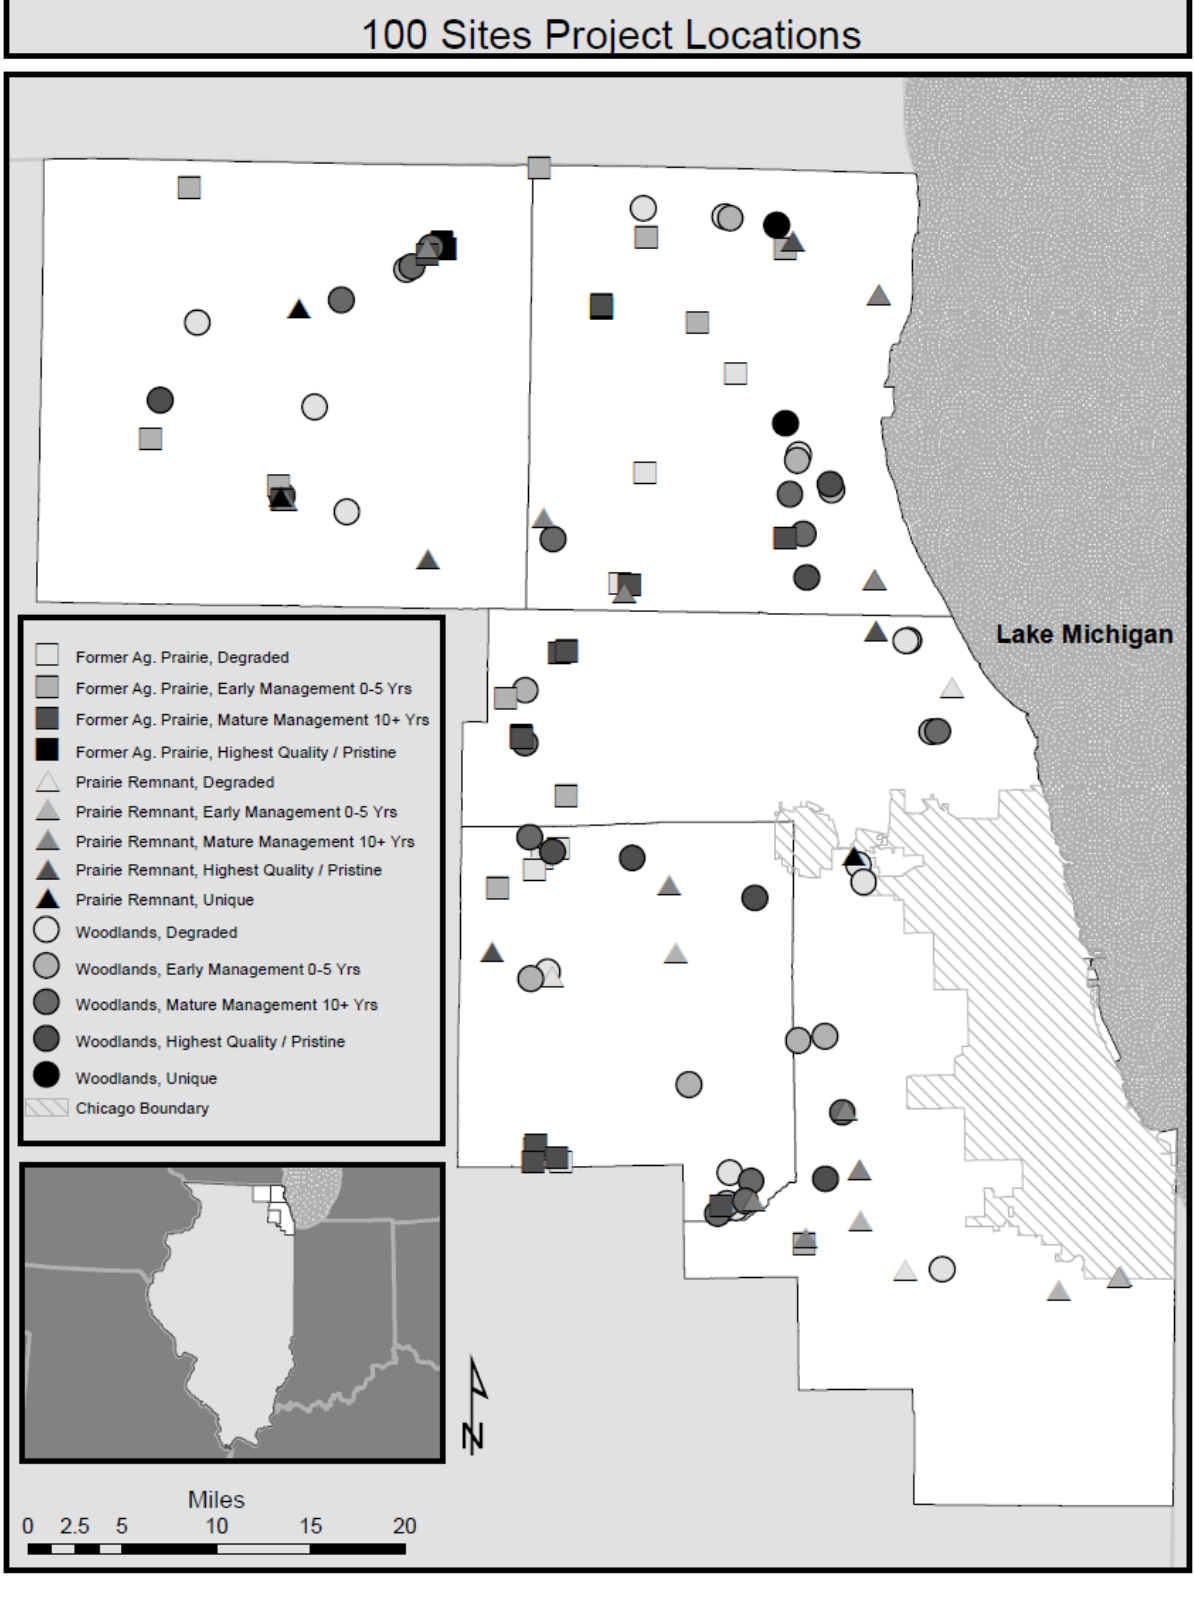
Figure A1. “100 Sites for 100 Years” This map show the distribution across the Chicagoland region of 100 one-hectare sites which are part of our “natural experiment” examining adaptive